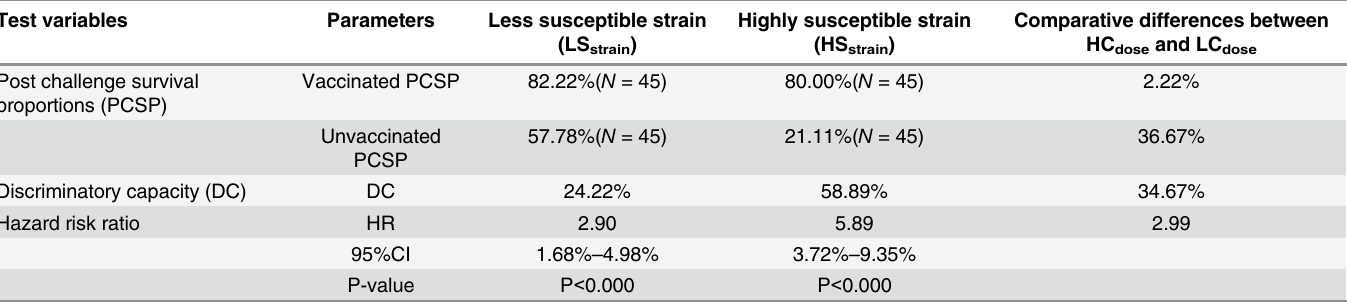
Table 3. Comparison of post challenge survival proportions and risk ratios of the high and low Atlantic salmon susceptible strains to NVI015-TA.